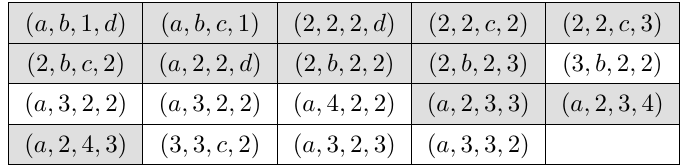
Table 19 . Infinite sequences of type XV singularities. The gray entries are either reducible to previous types or have at least one of c, d = 1 , which gives trivial 1-form symmetry. This table is adapted from